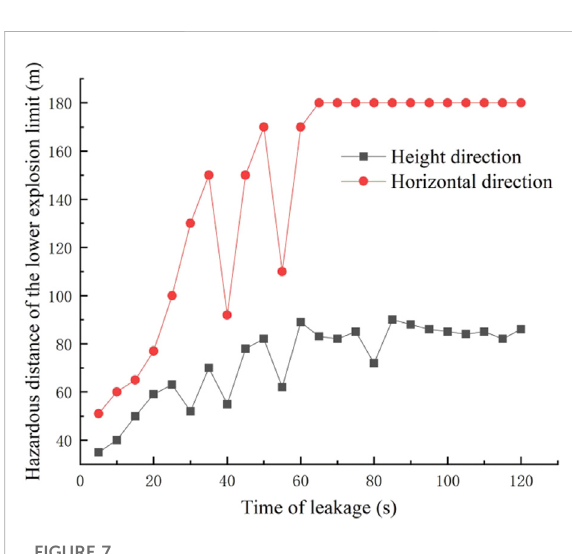
FIGURE 6 Concentration changes at monitoring points at different moments.